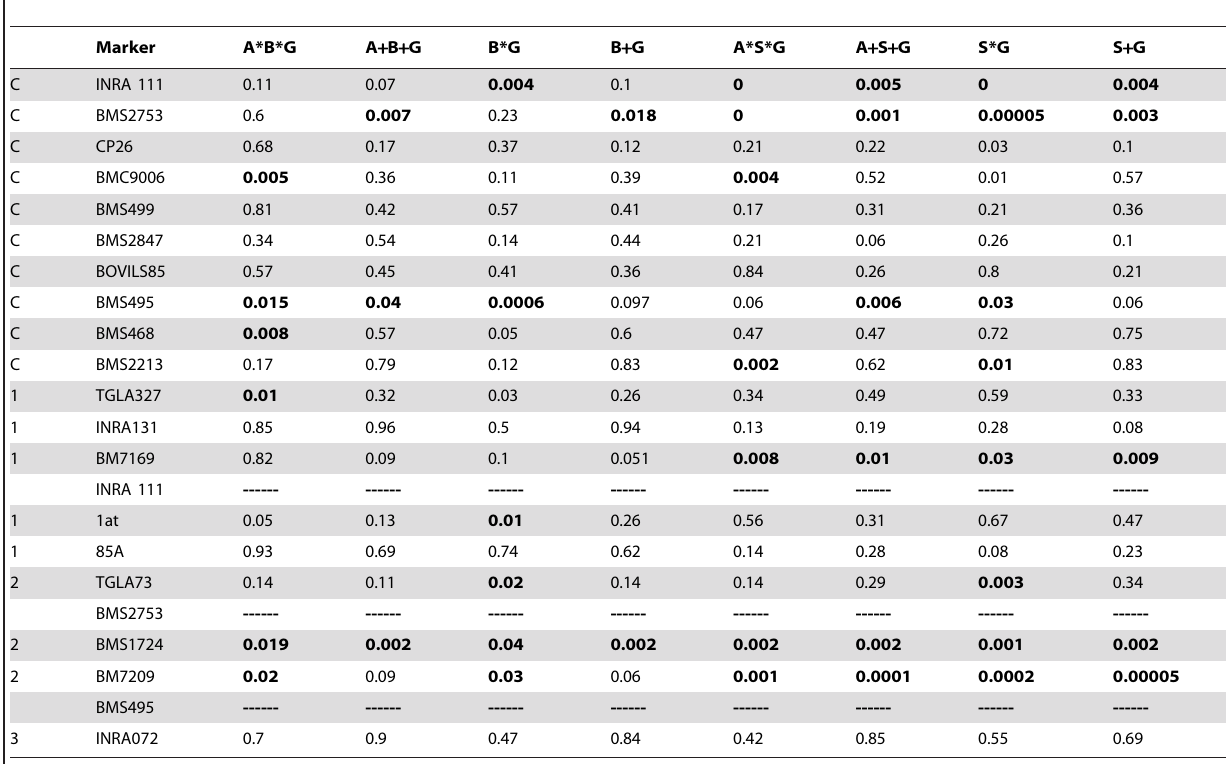
Table 3. Impact of fitting age in general linear models testing the strength of association between genotype and reactor status for the SICCT test of exposure to bovine